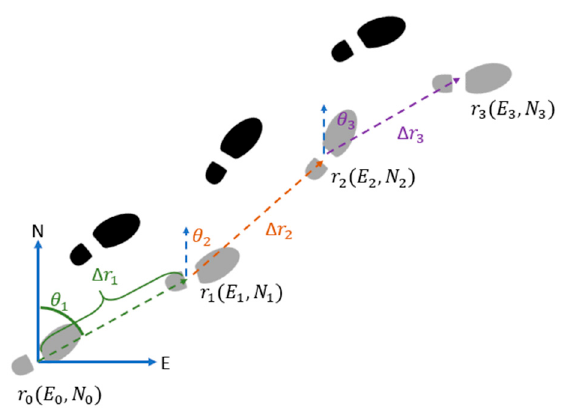
Figure 1. Pedestrian Dead Reckoning